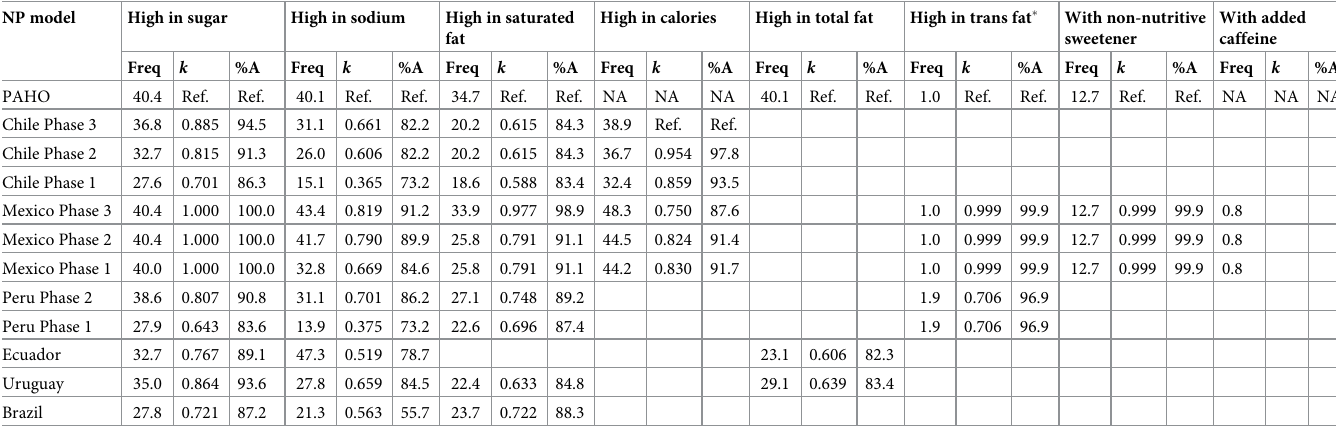
Table 2. Agreement of Latin American NP models with the PAHO model for the percentage of products with warnings for ingredients of concern, and with the Chilean model for the percentage of products with the warning “high in calories” ( n = 36,844 unique packaged